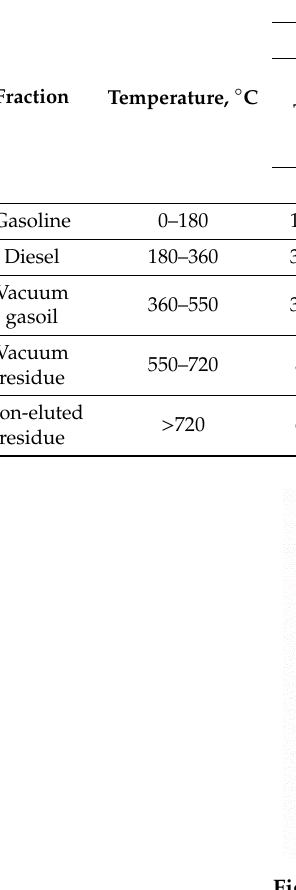
Table 9. Fraction distribution of liquid product formed by tar conversion in different systems.